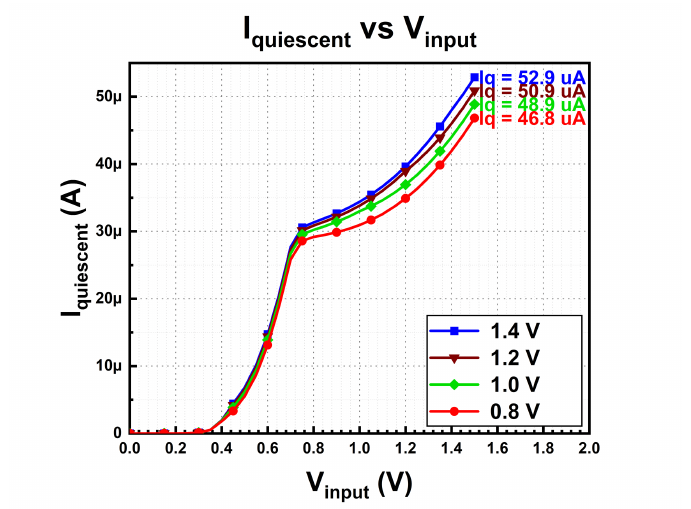
Figure 14. Quiescent current of proposed MVD-LDO. The load regulation on the multi-voltage domains is shown in Figure 15. The output voltage was measured while varying the load from no-load condition to full-load